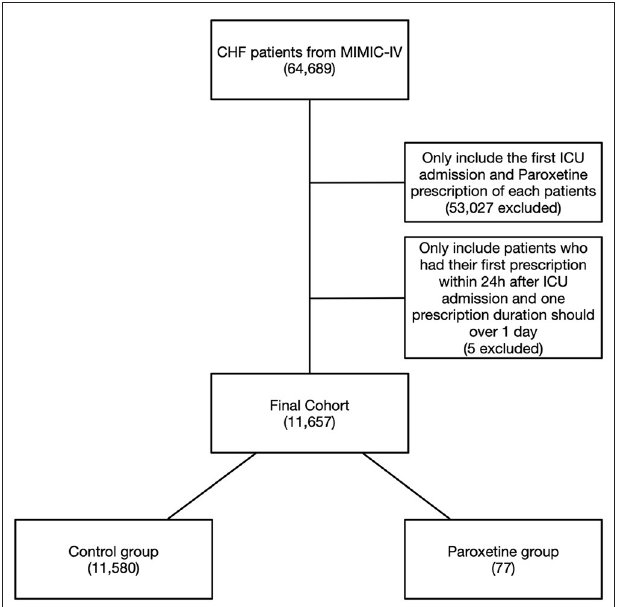
FIGURE 1 | Flowchart of study cohort. Illustration of exclusion and inclusion criteria used to select the final cohort of 11,657 patients. CHF, congestive heart failure; MIMIC-IV, Medical Information Mart for Intensive Care